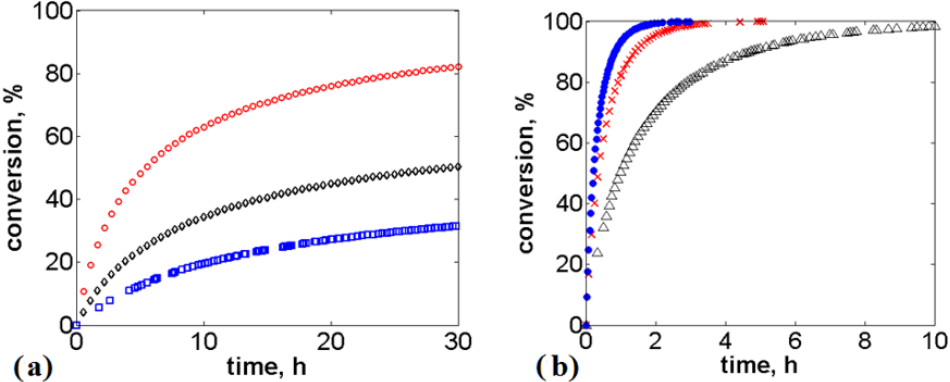
Figure 5. ( a ) Plot of amount of urea reacted vs. time considering values of phosphoric acid concentration between 1 and 2.5. ( Ο ) C (cid:4666)(cid:2892) 1.5, C (cid:4666)(cid:2887)(cid:2892) (cid:3404) 1, k (cid:3404) 1 (cid:3400) 10 (cid:2879)(cid:2873) ; ( □ ) C (cid:4666)(cid:2892) (cid:3120) (cid:2898) (cid:3118) (cid:2899)(cid:4667) 𝟎